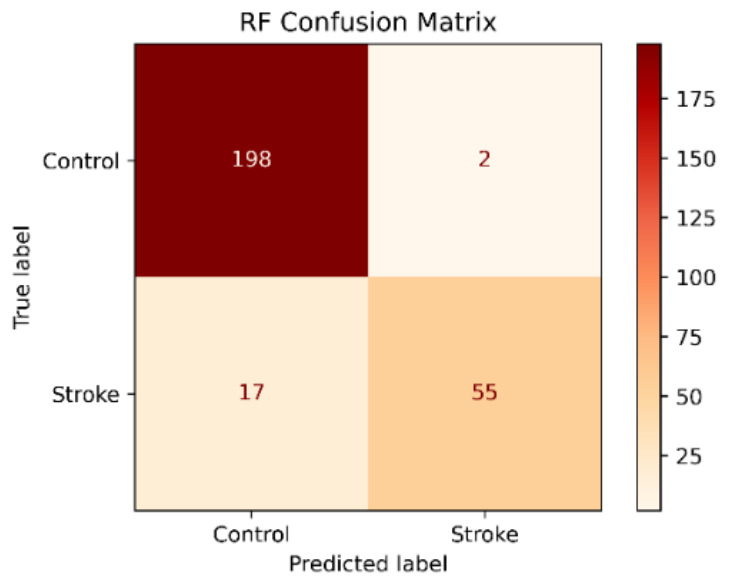
Table 3. Random Forest model classification report.